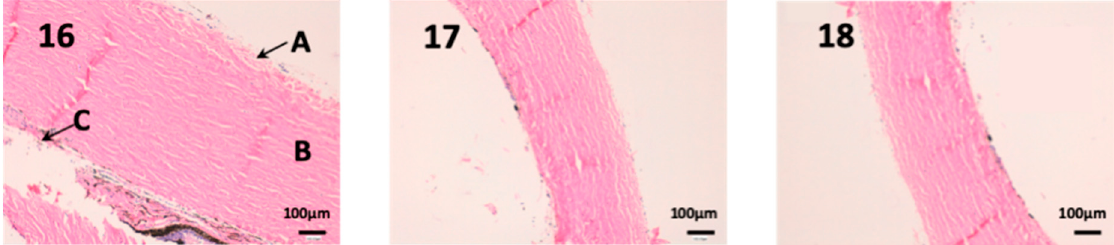
Figure 13. Photo 16: Histological image of untreated sclera observed at 400× ; Photo 17: Histological